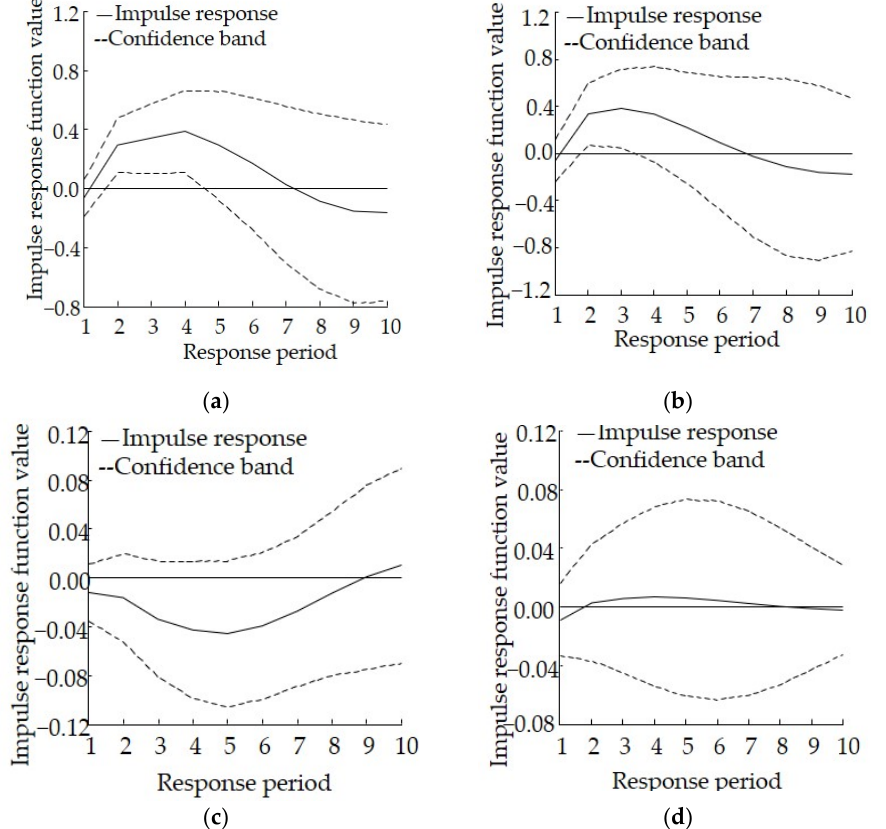
Figure 3. Impulse response relationship between industrial structure adjustment and the discharge of pollutants to the aquatic environment in Gansu, ( a ) Impulse response of lnCOD to lnSI, ( b ) Impulse response of lnAN to lnSI, ( c ) Impulse response of lnSI to lnCOD, ( d ) Impulse response of lnSI to lnAN.